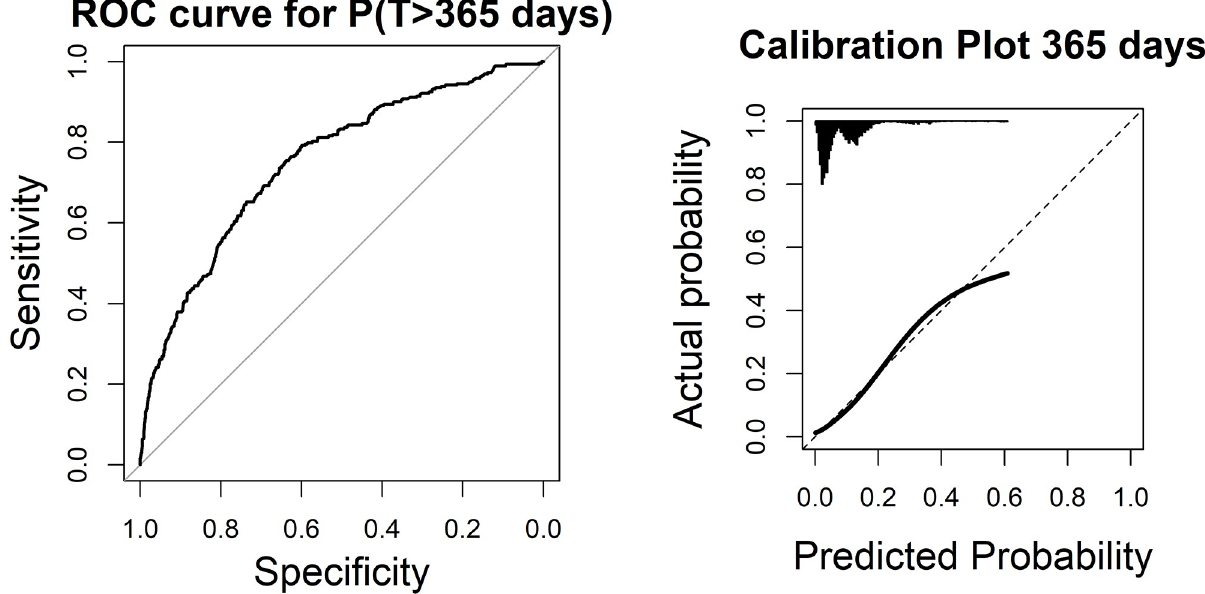
Fig 3. Receiver-operating characteristics (ROC) curves and boxplots of predicted duration of a sickness absence (SA) spell for outcomes A; SA > 90, B; SA > 180, and C; SA > 365 days, respectively. The corresponding c -statistic is defined as the area under the ROC curve (AUC). The diagonal line in the ROC curve indicates a c -statistic of 0.5, no better discrimination than random chance.